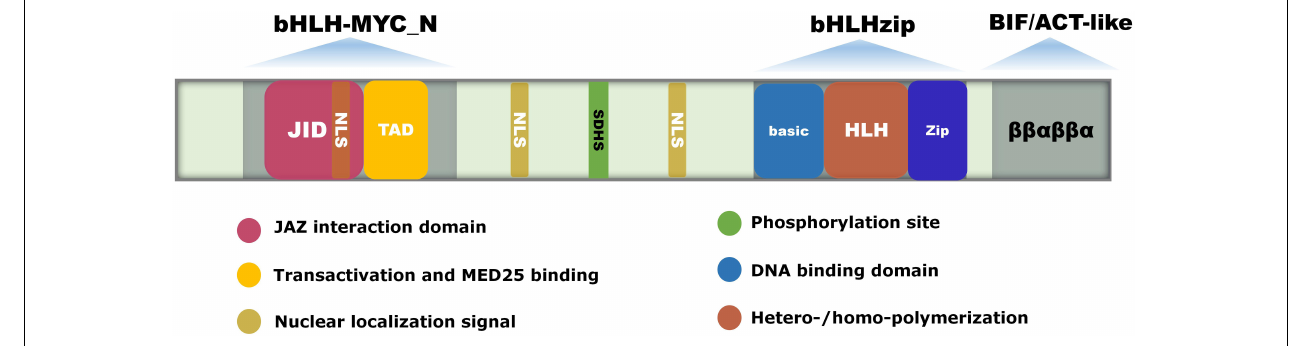
FIGURE 1 | The gene structure and conserved domains of MYC2. bHLH-MYC_N, bHLH-zip, and BIF/ACT-like are the three conserved domains of MYC2. The bHLH domain at the C-terminus is composed of the Basic and HLH domains, and the N-terminus contains the JID and TAD domains. The Basic domain is responsible for binding to the G-box in the promoter of the targeted gene. The HLH domain is responsible for forming homo- or heterodimers. The JID domain binds to the Jas domain of the JAZ protein, and the TAD domain is responsible for transactivation and interactions with the MED25 subunit. The BIF structural domain contains a ββαβββα structure similar to the ACT domain, and is responsible for transactivation and homodimer formation. NSL is the nuclear localization signaling structure. The conserved amino acid SDHS is the phosphorylation